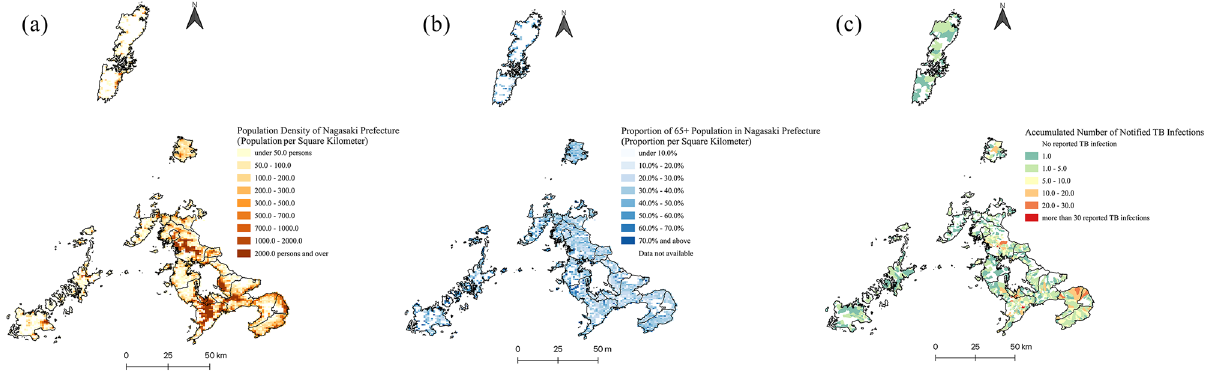
Figure 1. Population distribution and accumulated TB infections from 2007 to 2018 in Nagasaki Prefecture. ( a ) The data of population per 1 km 2 is from the 2015 population census of Japan; ( b ) The proportion of people older than 65 years per 1 km 2 was calculated from the 2015 population census of Japan; ( c ) The number of notified TB infections from 2007 to 2018 is accumulated by boundaries of “ machi ” (the 4th level of administrative divisions in